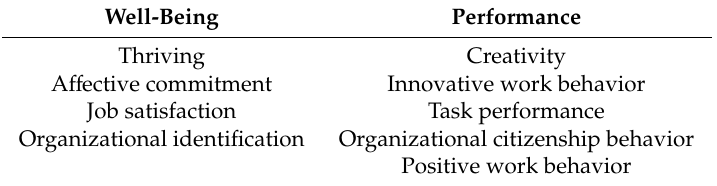
Table 3. Categorizations of work outcomes for Meta Structural Equation Modeling